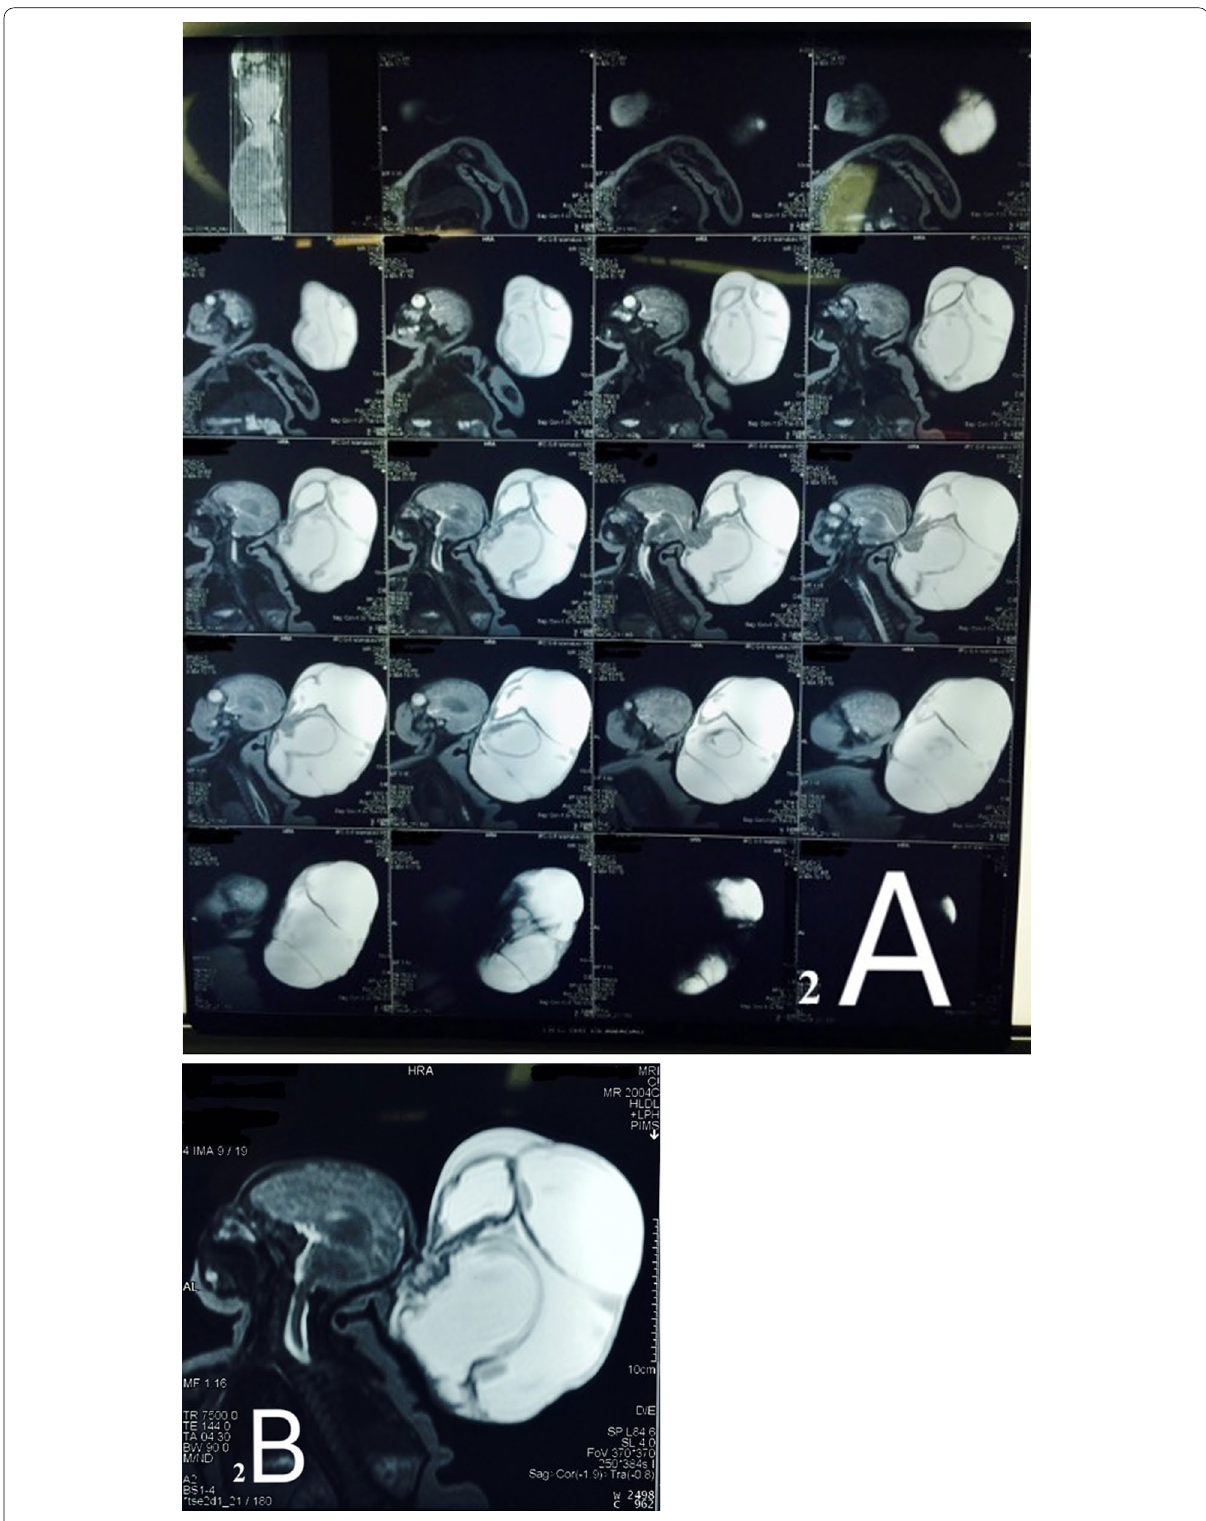
Fig. 2 A MRI T2 weighted image of Giant Occipital Meningoencephalocele. B MRI T2 weighted image showing a huge meningoencephalocele without